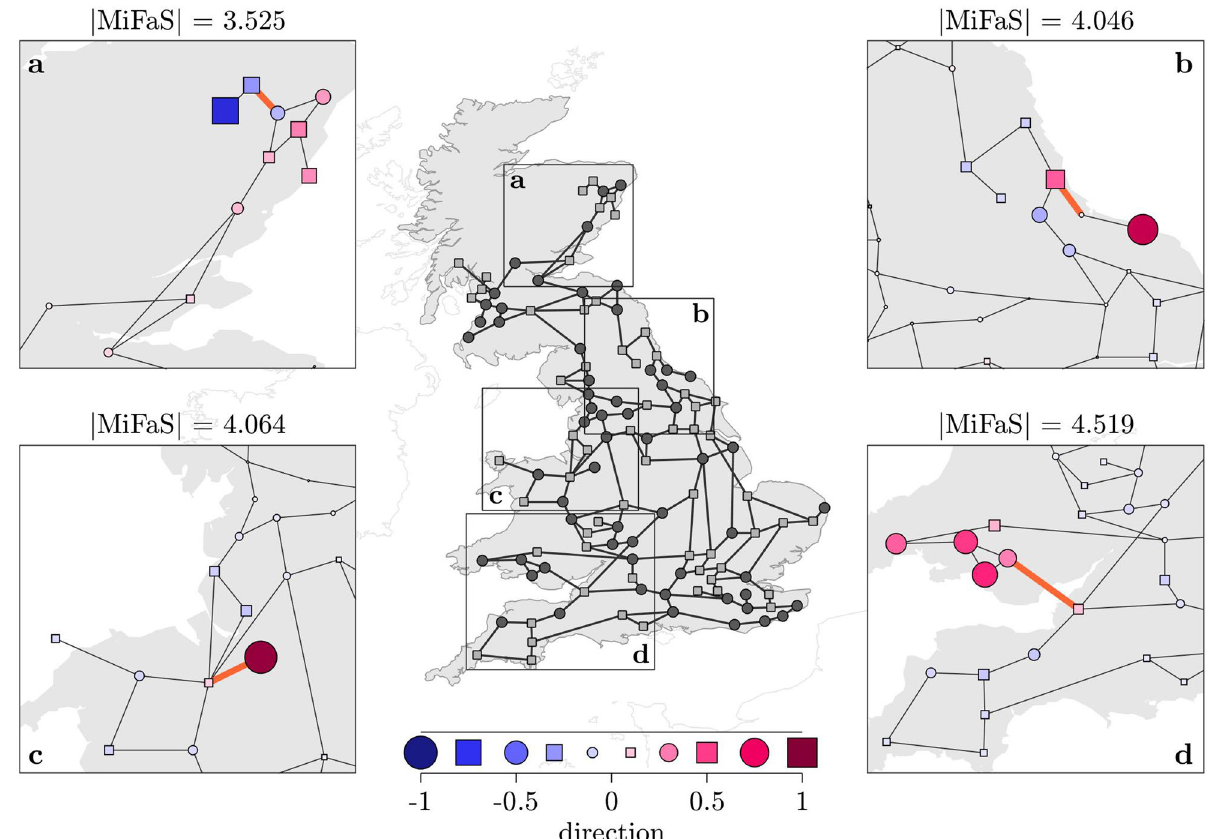
Figure 5. Local Minimal Fatal Shocks in the Great Britain power grid. Direction of the local MiFaS. The perturbation vectors are scaled to a length of 1. The relative contribution of each element of the vector (node in the network) to the overall perturbation is represented by the area and the color saturation of the respective squares and circles. A blue coloring denotes a deceleration and a pink coloring an acceleration at the respective node. Squares portray consumers and circles generators. ( a – d ) Blow-ups of the significantly perturbed area of four local MiFaS which correspond to different outcomes of the optimization process. Highlighted edges represent the trigger transmission line of the particular perturbation. The figure was generated using MATLAB version R2020a (https ://www.mathw